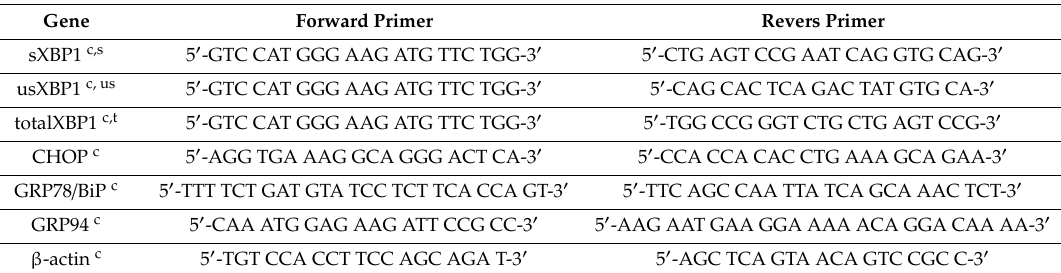
Table 2. Primers for qRT